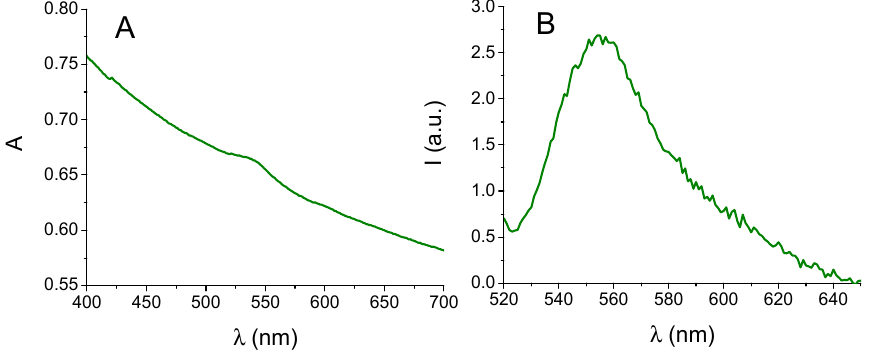
Figure 2. ( A ) Absorption and ( B ) fluorescence emission spectra ( λ exc = 510 nm) of PS-MSNs suspension (1 mg mL − 1 ) in PBS (pH 7.4, 10 mM).